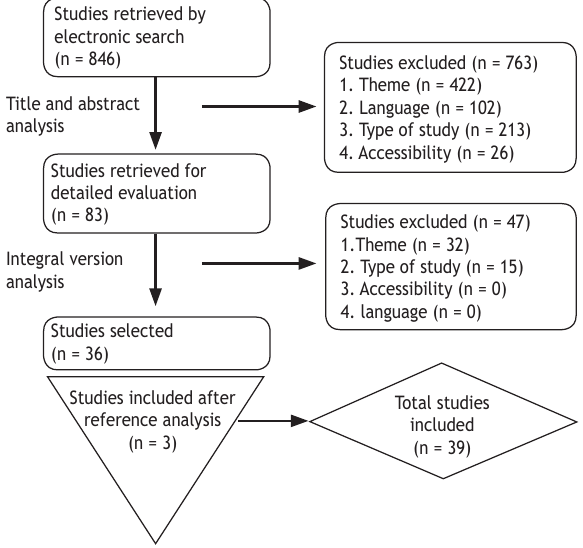
Figure 1 Flowchart of article selection. The query used was: (postoperative complications[MeSH Terms]) OR postop - erative complications[Title/Abstract]) OR postoperative complication[Title/ Abstract]) OR postoperative complication[MeSH Terms]) OR